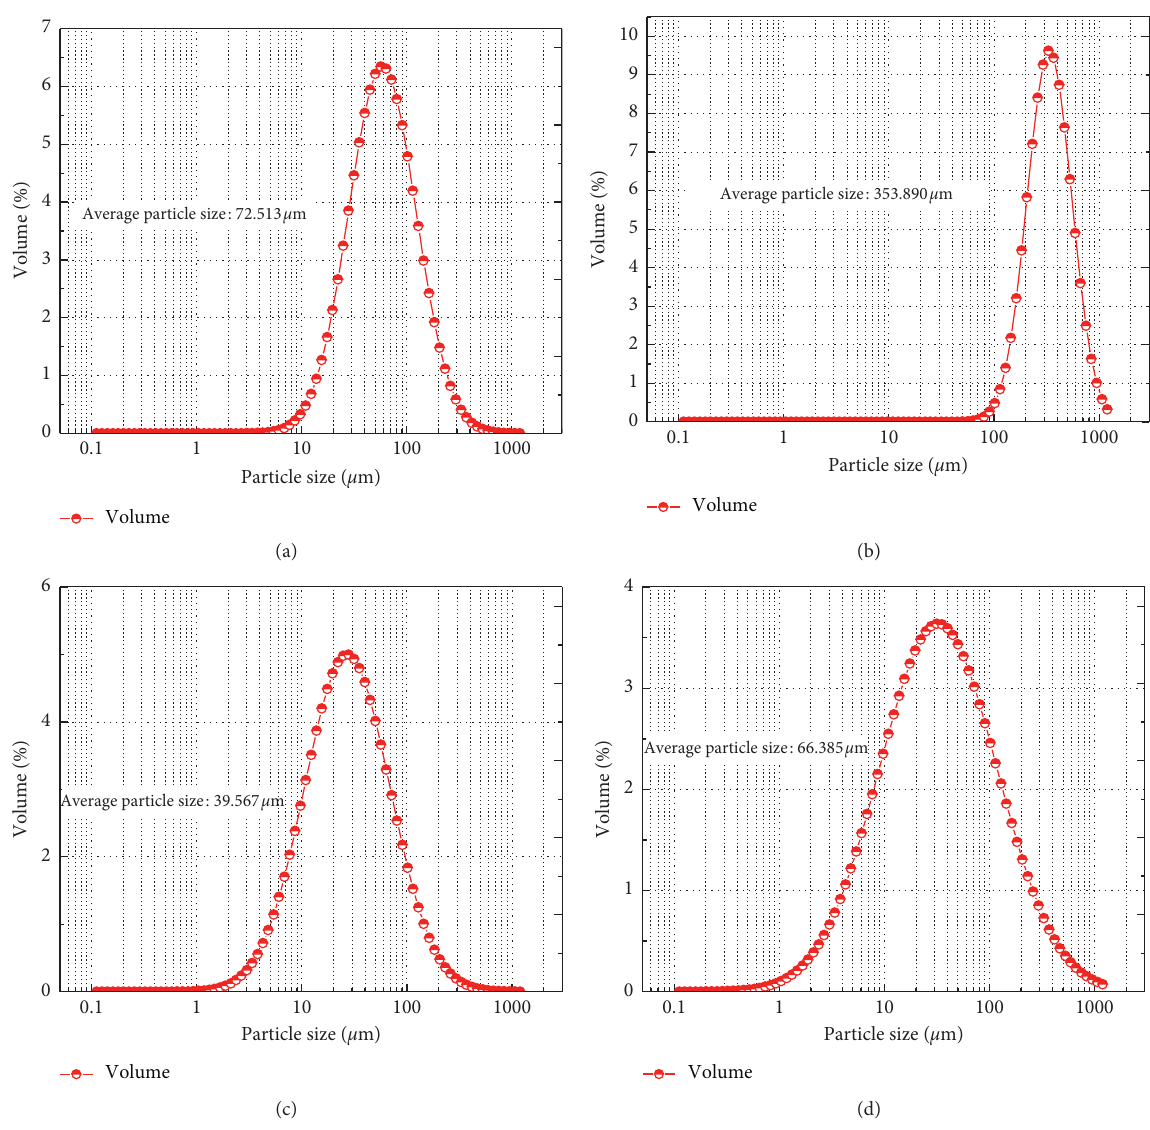
Figure 3: Particle size distributions. (a) Fly ash. (b) Aeolian sand. (c) Cement. (d) Quicklime.